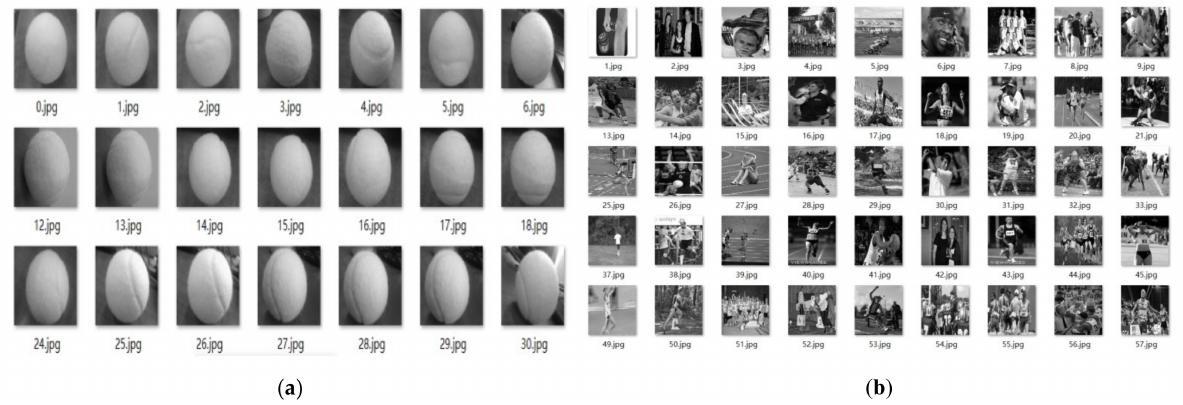
Figure 7. Positive and negative sample description files. ( a ) Positive Sample, ( b ) negative sample.